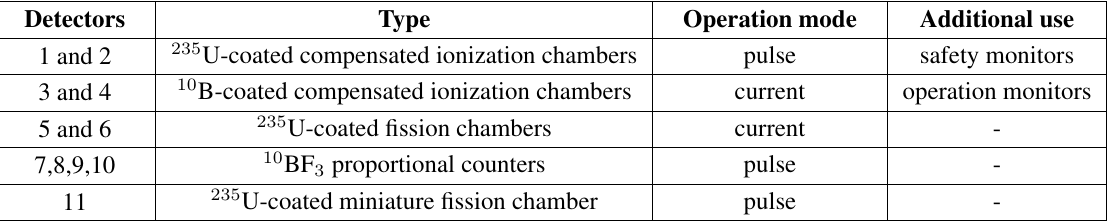
Table 1: Detectors used in the COLIBRI